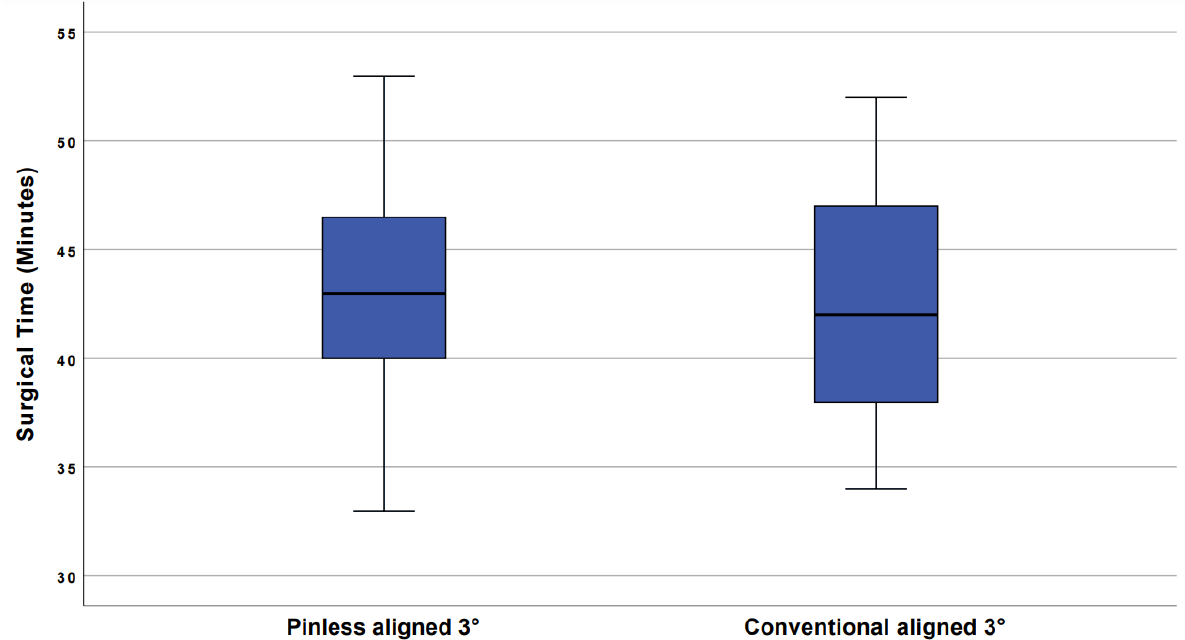
Figure 7. Mean incision to suture time. Boxplots show range of incision to suture time. In the navigation technique, the range and mean time was slightly higher. One outlier with 62 min in the navigation group was noticed.